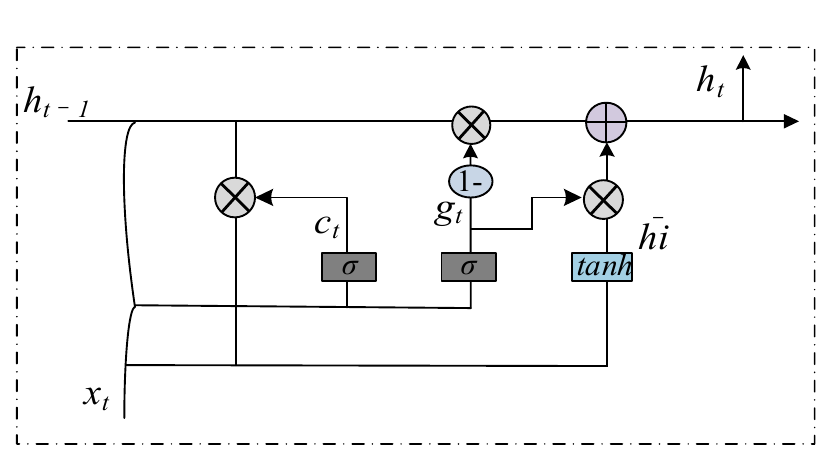
Figure 4. The structure of GRU.